Question: Write a descriptive caption for this figure.
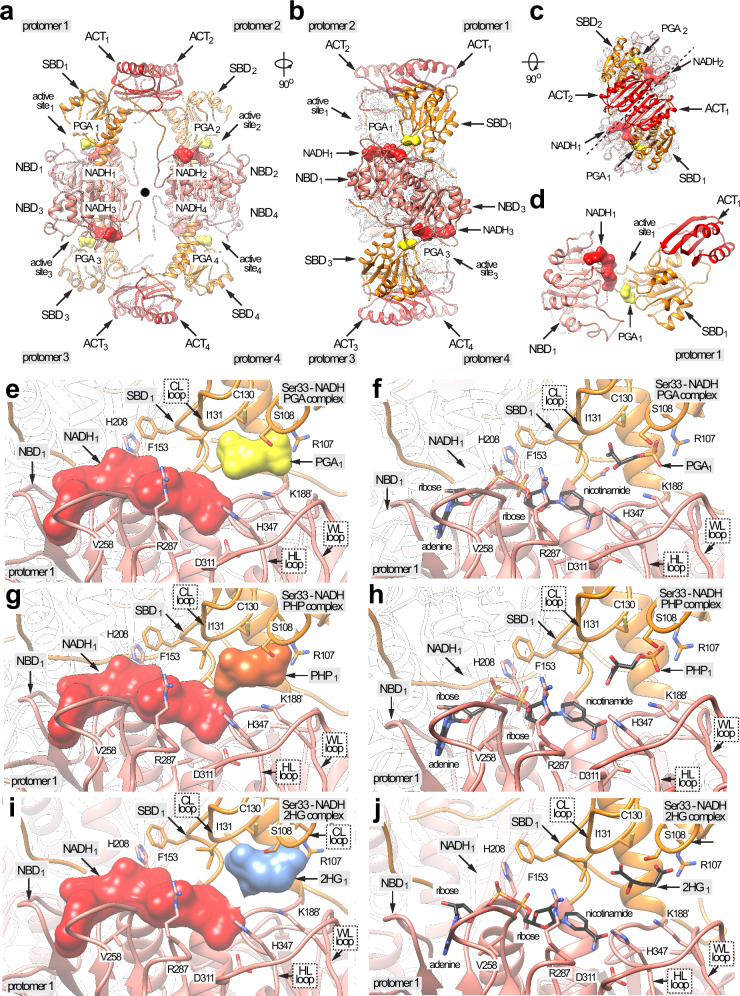
Answer: The active site of Ser33. a – c The overall structure of the Ser33 homotetramer in complex with NADH and PGA. All protomers are shown in cartoon representation, including the NBD domains (salmon), the SBD domains (orange), and the ACT regulatory domains (red). The NADH and PGA ligands are shown in surface representation (red and yellow, respectively). The solid circle corresponds to a 2-fold axis. d Close-up view of the Ser33 protomer active site, showing the location of NADH and PGA. e , f Close-up view of the Ser33 active site in the Ser33-NADH-PGA complex (PDB code 8PIR ), showing the location of NADH (red) and PGA (yellow). g , h Close-up view of the Ser33 active site in the Ser33-NADH-PHP complex (PDB code 8PIO ), showing the location of NADH (red) and PHP (orange). i , j Close-up view of the Ser33 active site in the Ser33-NADH-2HG-SER complex (PDB code 8Q2I ), showing the location of NADH (red) and 2HG (blue).